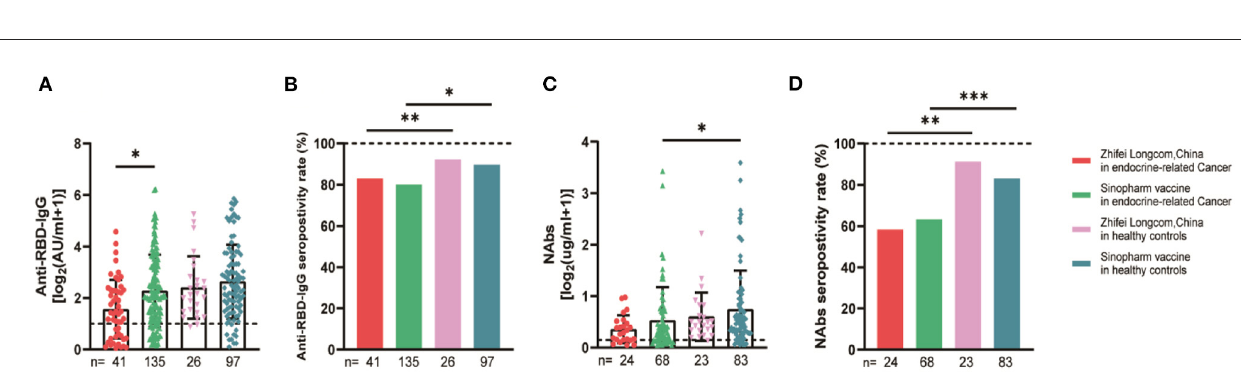
FIGURE5 Antibody responses to SARS-CoV-2 vaccines in participants of different vaccine types. Subgroup analysis of the titers and seropositivity rate of anti-receptor binding domain (RBD)-IgG (A, B) and NAbs (C, D) in participants according to vaccine type. The horizontal dotted lines represent the limit of detection. The error bars represent the median (IQR) (* P < 0.05, ** P < 0.01, *** P < 0.001). NAbs, neutralizing antibodies; IQR, interquartile range; RBD, receptor binding